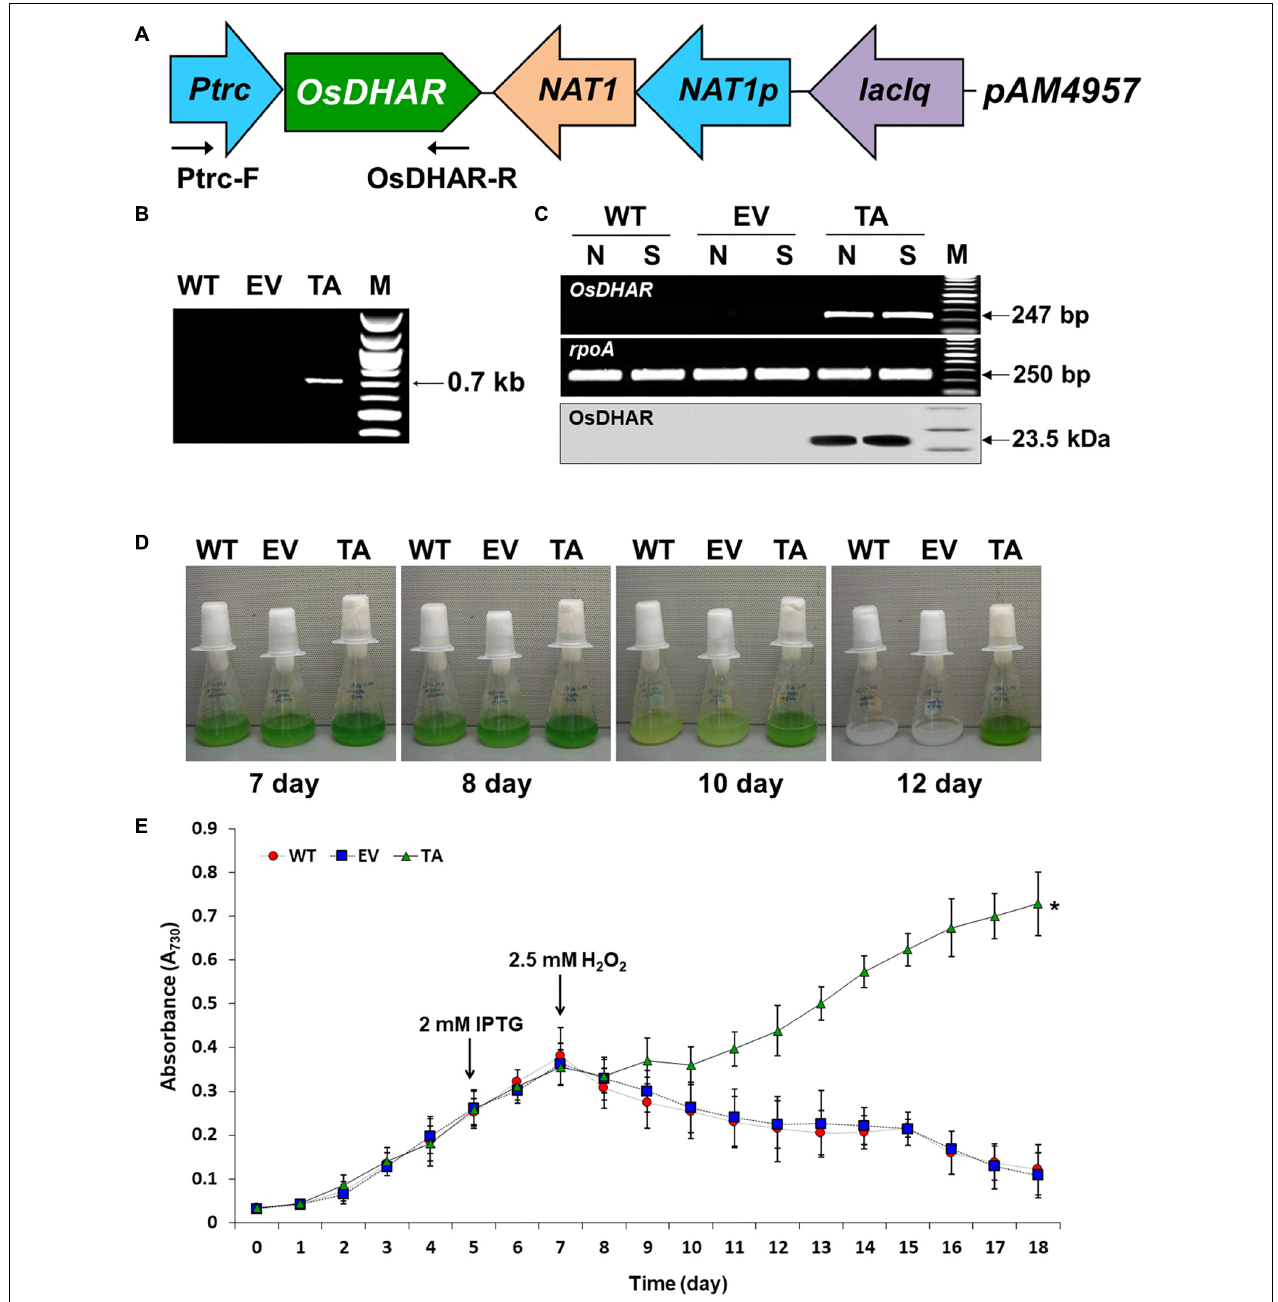
FIGURE 2 | Expression of the OsDHAR gene in the S. elongatus PCC 7942. (A) Schematic showing expression of OsDHAR in of S. elongatus PCC 7942. Ptrc , IPTG-inducible promoter; OsDHAR , dehydroascorbate reductase gene of O. sativa ; NAT, antibiotic nourseothricin selection marker (cloNAT); and LacIq , lactose repressor promoter. Arrows indicate the direction of each gene. (B,C) PCR results verifying OsDHAR gene integration in the genome of the transgenic TA. (B) PCR of OsDHAR gene in transgenic TA to confirm genotype (690 bp). (C) Expression of the OsDHAR gene was confirmed by semi-quantitative RT-PCR (247 bp) and Western blot (23.5 kDa). N, normal conditions; S, stress conditions. The rpoA transcript was used as a control standard in the analysis (250 bp). (D,E) Growth profiles of the TA, EV, and WT S. elongatus PCC 7942. Growth levels of the different S. elongatus PCC 7942 were compared to determine whether the TA grew better under H 2 O 2 stress conditions. After 7 days of growth under standard conditions, the TA, EV, and WT S. elongatus PCC 7942 were adjusted to an absorbance at 730 nm of 0.3 to 0.35 and then grown in BG11 medium containing 2.5 mM H 2 O 2 , then cultured for 18 days at 30 ◦ C with shaking in liquid microbial lab flasks. WT, WT S. elongatus PCC 7942; EV, empty vector S. elongatus PCC 7942; TA, TA S. elongatus PCC 7942. Error bars indicate ± SD of biologically least three independent experiments. Asterisks indicate significant differences between treatments as estimated by Student’s t -test ( P < 0.05).